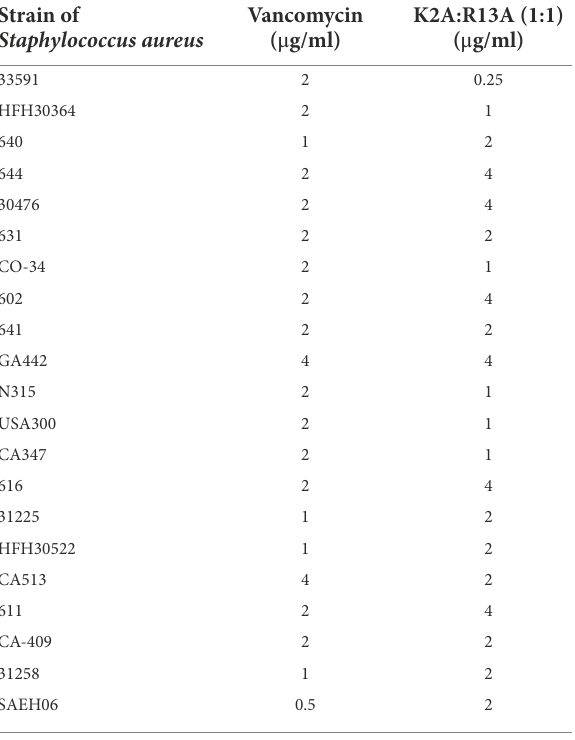
TABLE 2 MICs ( μ g/ml) of combined K2A:R13A analogs and vancomycin against a panel of clinical MRSA isolates in broth. Strain of Staphylococcus